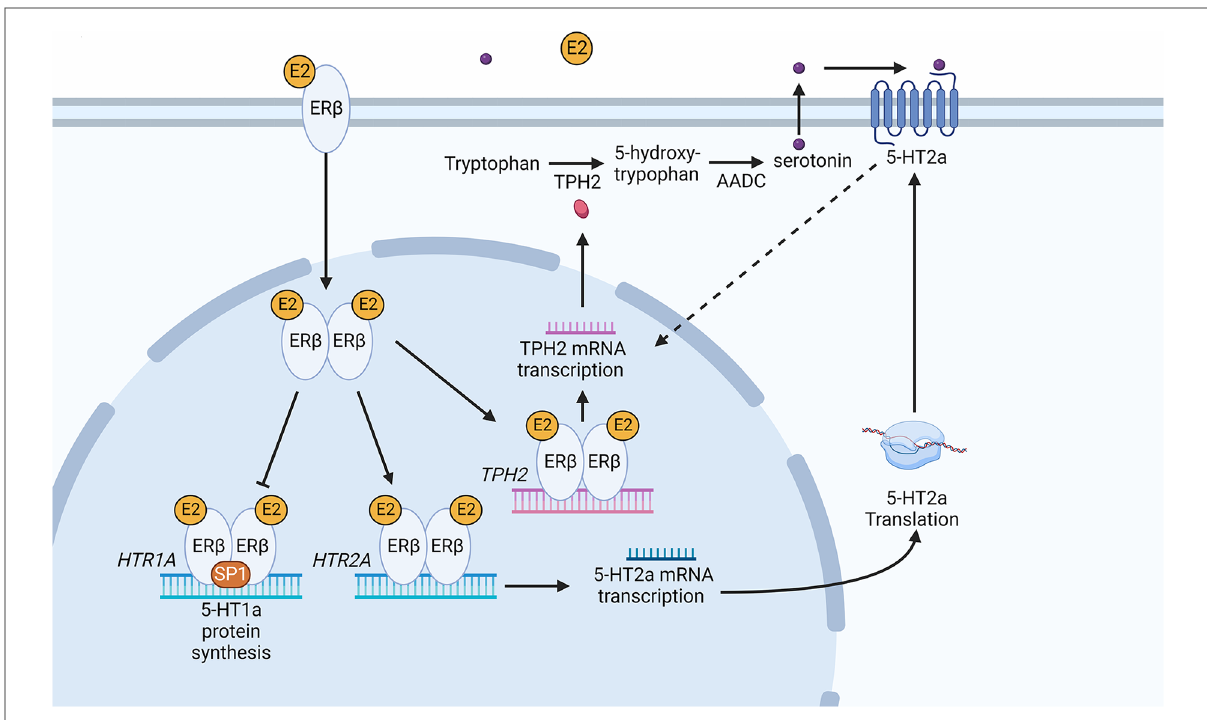
FIGURE 1 Schematic diagram of the serotonin synthesis pathway following an increase in oestradiol in the peripheral nervous tissue. The increase in E2 leads to the activation of ER β causing it to dimerize. Dimerized ER β interacts with SP1 to inhibit HTR1A receptor transcription. Secondly, ER β causes transcription of the HTR2A receptor gene, increasing 5-HT2a receptor protein in the cell. An increase in 5-HT2a results in an increase in tryptophan hydroxylase 2 (TPH2) mRNA and subsequently TPH2 protein. The dotted line represents an indirect induction of TPH2 by 5HT2a. Dimerized ER β directly induces TPH2 transcription leading to TPH2 protein synthesis. TPH2 catalyses the conversion of tryptophan into 5- hydroxytryptophan, which is then converted into serotonin (5-hydroxytryptamine) via aromatic l -amino acid decarboxylase (AADC). Serotonin binding with 5-HT2a leads to positive feedback increasing TPH2 and resulting in serotonin production. Created with